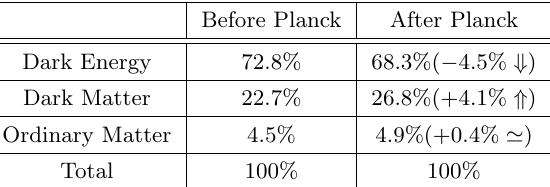
Table 1: Universe composition from